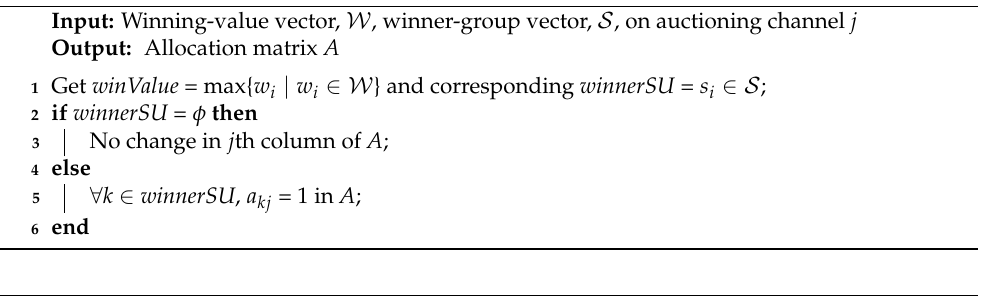
Algorithm 3: Pricing